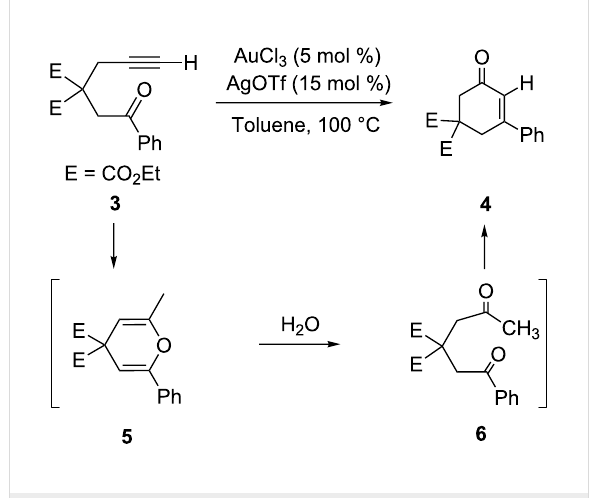
Scheme 4: Gold-catalyzed cyclization of terminal alkynyl